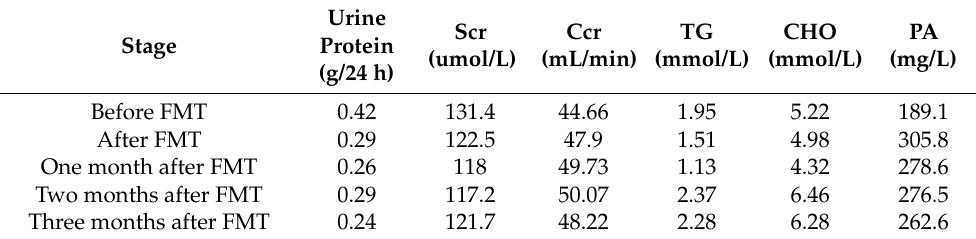
Table 1. Changes in clinical indicators before and after